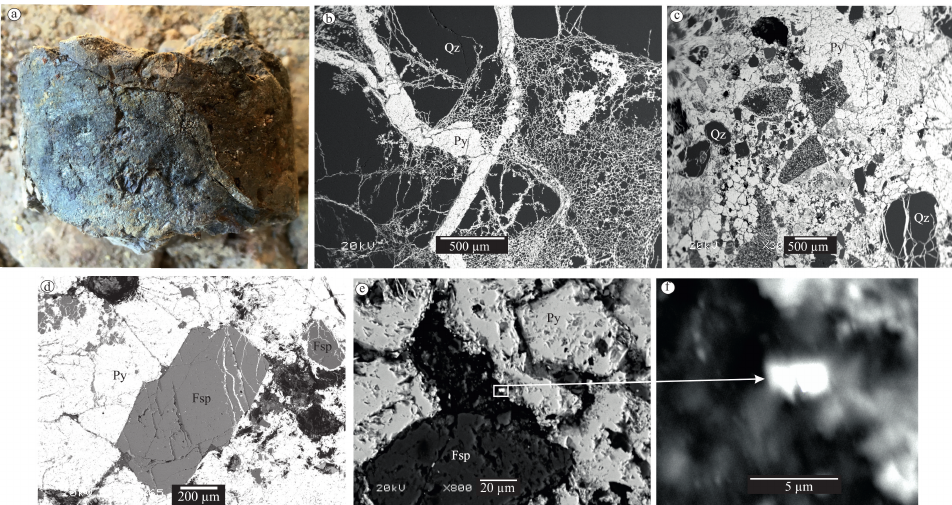
Figure 12. Hydrothermal-metasomatic formations developed by slightly cemented fine-pebble quartz conglomerates of the Early Permian age of the Anabar region: ( a ) core sample of pyritized conglomerate (interval 39.7–40 m of well A-3 of exploration line 21; sample 21-A3-5, microphotography); ( b , c ) types of pyrite mineralization (BSE mode): ( b ) net-vein; ( c ) entire; ( d ) pyrite-potassium feldspar mineralization in quartz conglomerates (BSE mode); ( e , f ) the smallest gold particle in a mineralized conglomerate (BSE mode). Qz—quartz; Fsp—potassium feldspar; Py—pyrite. Jasperoids are apocarbonate rocks with a SiO 2 content from 81 to 96.5%. Their char- acteristic feature is the oolitic structure. In these formations chalcedonic quartz almost completely replaces dolomites (Figure 13). Only very small relics of them are observed in the central parts of the oolites.